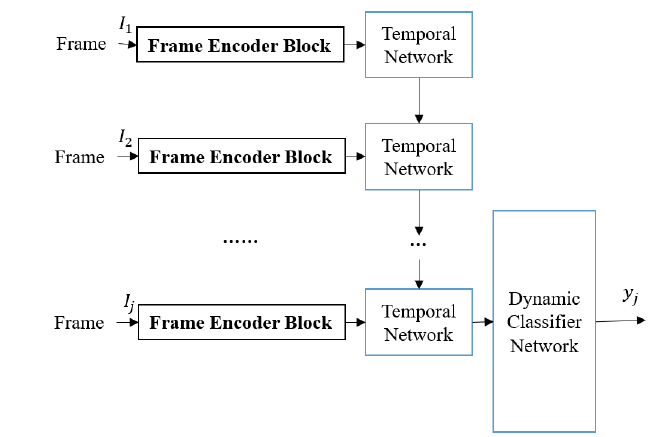
Figure 3. The third training stage: (Blue boxes indicate the sub-network that will be trained.) Stage 3 is used to train the Dynamic Attention Convolutional Network